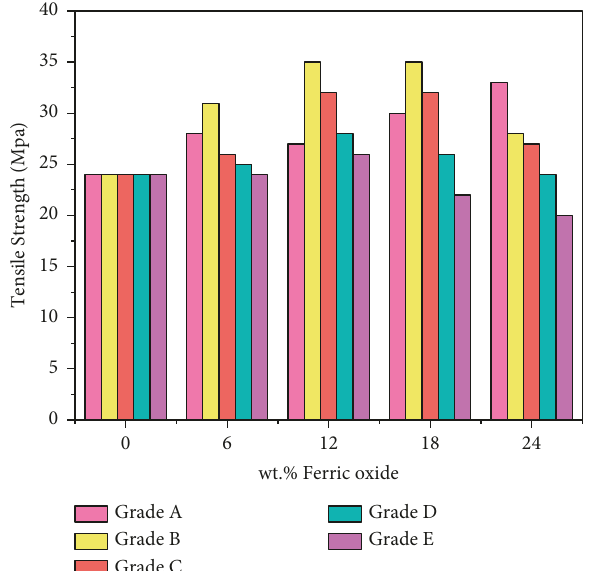
Figure 5: Impact of weight fractions and size of iron oxide particles on the tensile strength of polyethylene/ferric oxide